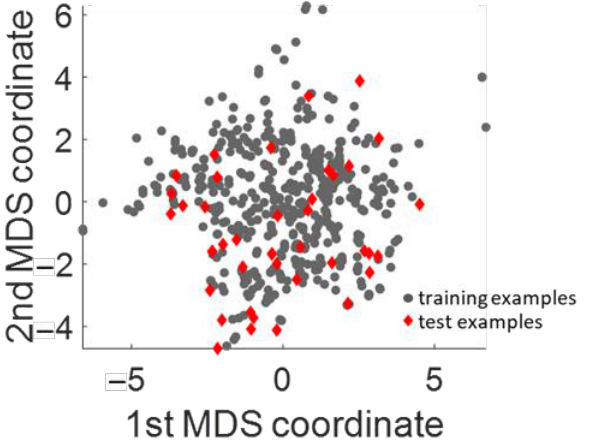
Figure 13. Distributions of training/test samples after applying the balancing procedure. Grey dots: training examples; red dots: test examples.